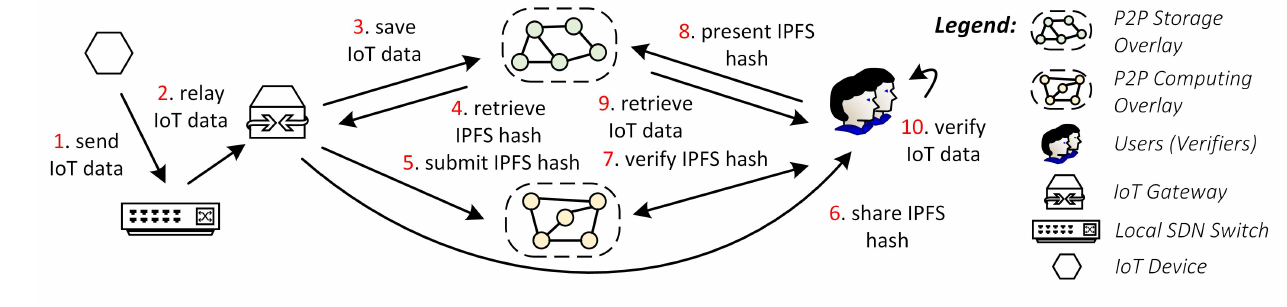
Figure 4. Storing and verifying IoT data, highlighting a possible storage workflow in our architecture.